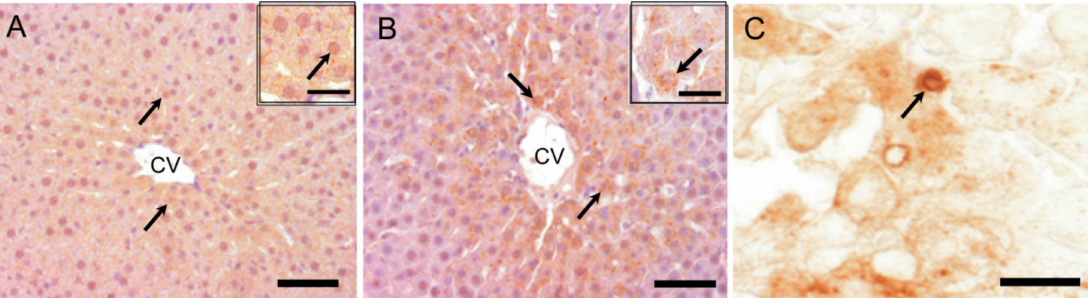
Figure 12. Immunohistochemistry for LC3B in APAP-induced rat hepatotoxicity. LC3B positive cytoplasmic fine granules in hepatocytes (arrows) are sporadically detected at basal level in the control liver ( A ). Compared to the control expression, intracytoplasmic LC3B labeled granules in hepatocytes (arrows) are increased in the centrilobular area with a peak on day 1 ( B ) (Table 1). Abnormally-developed LC3B positive autophagosomes, apparently vacuolated granules, are occasionally seen in some hepatocytes ( C ), suggestive of abnormality of formation (arrow). Insets are higher magnifications. Immunohistochemical staining, counterstained with hematoxylin. CV, central vein; LC3B, microtubule-associated protein light chain 3. Bar = 50 µ m (A–B), 15 µ m (C), inset bar = 20 µ m. Table 1. Semi-quantitative analysis for LC3B immunoexpression in the a ff ected centrilobular area.